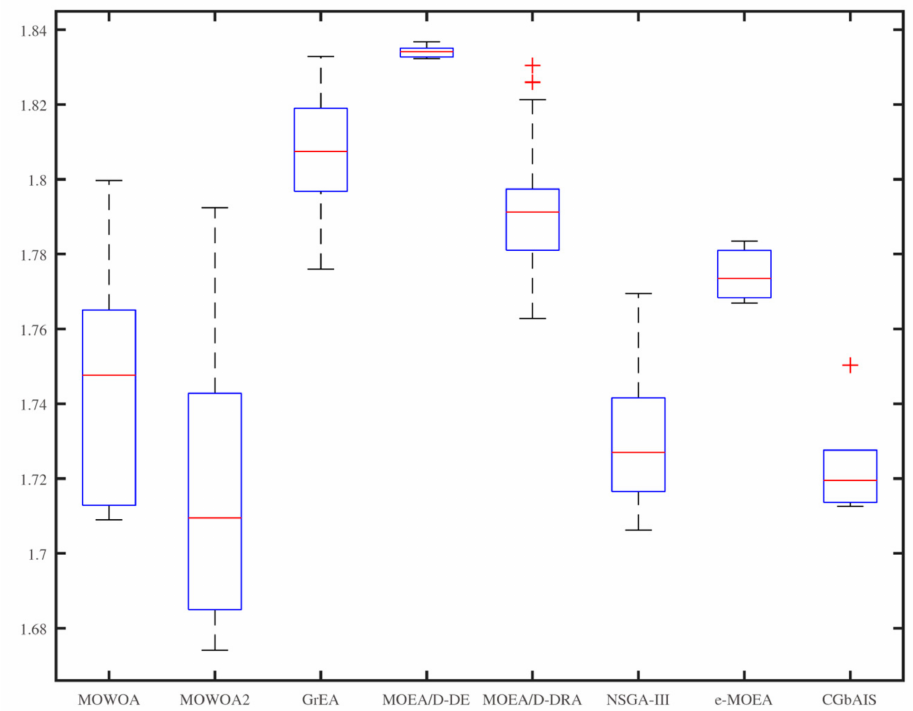
Figure 10. Time consumption of the different algorithms when the user number is